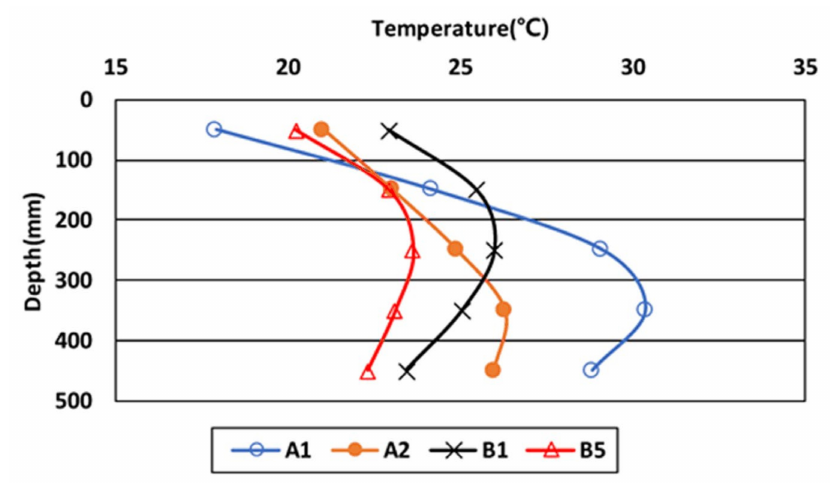
Figure 8. Temperature gradient according to the slab depth at the final setting